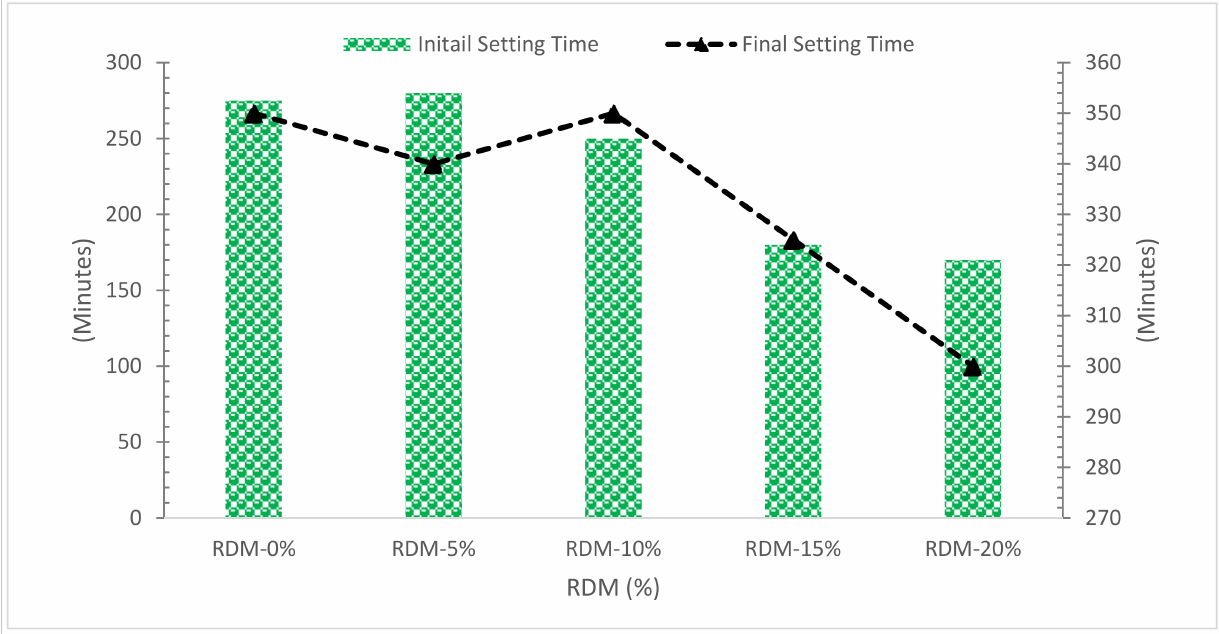
Figure 8. Setting Time